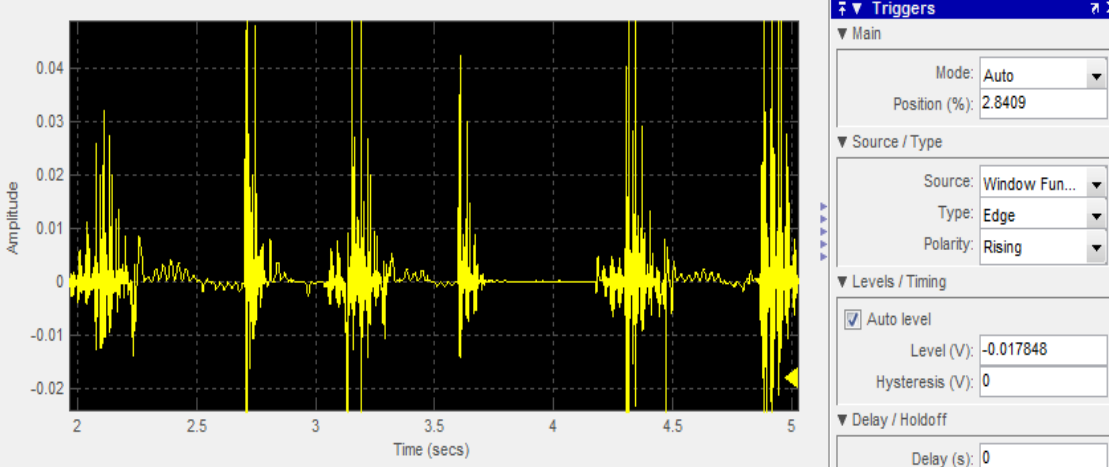
Figure 13. Multiplied by Hamming Windows time domain distribution.